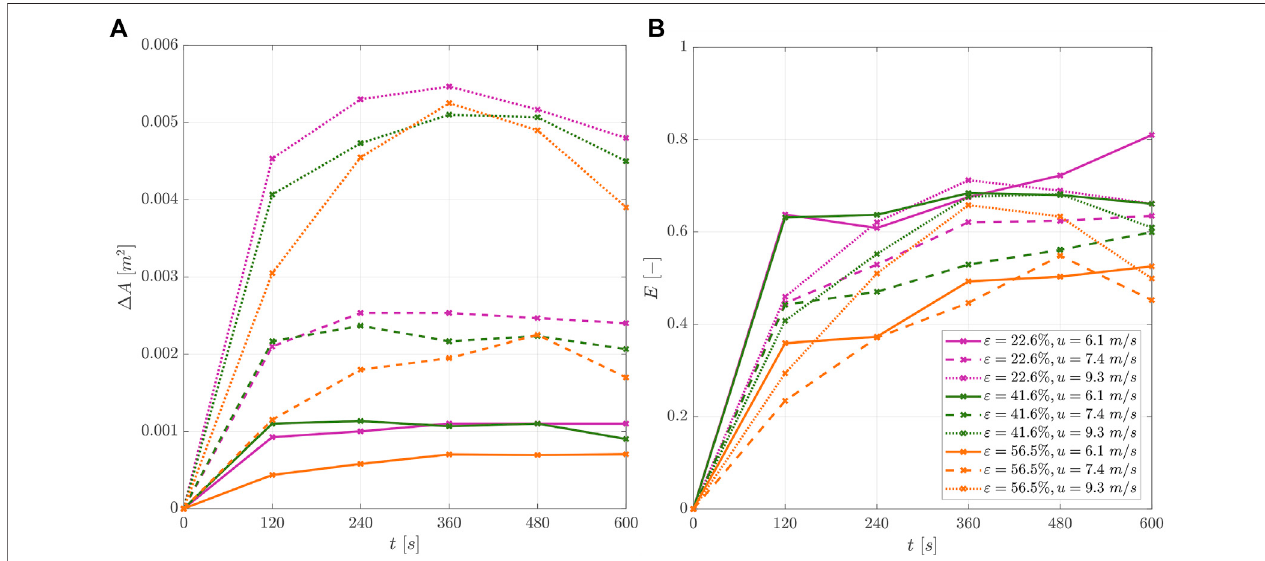
FIGURE 13 | Change of (A) cross-sectional area Δ A (-) and (B) trap ef fi ciency E (-) for different investigated fence con fi gurations varying in fence porosities ε ε ε 1 = 22.6%, 2 = 41.6%, and 3 = 56.5% for investigated wind velocities u 1 = 6.1 m/s, u 2 = 7.4 m/s, and u 2 = 9.3 m/s expressed over the experiment duration t (s).